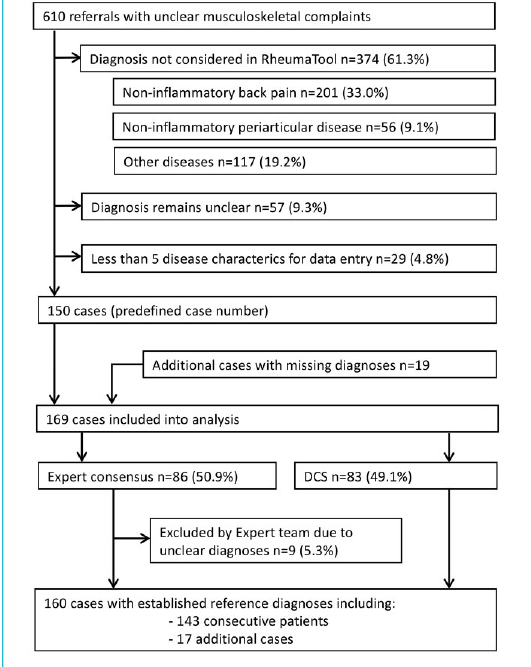
Figure 2: Case selection with the number of cases and the per- centage in parenthesis. DCS = disease criteria sets.